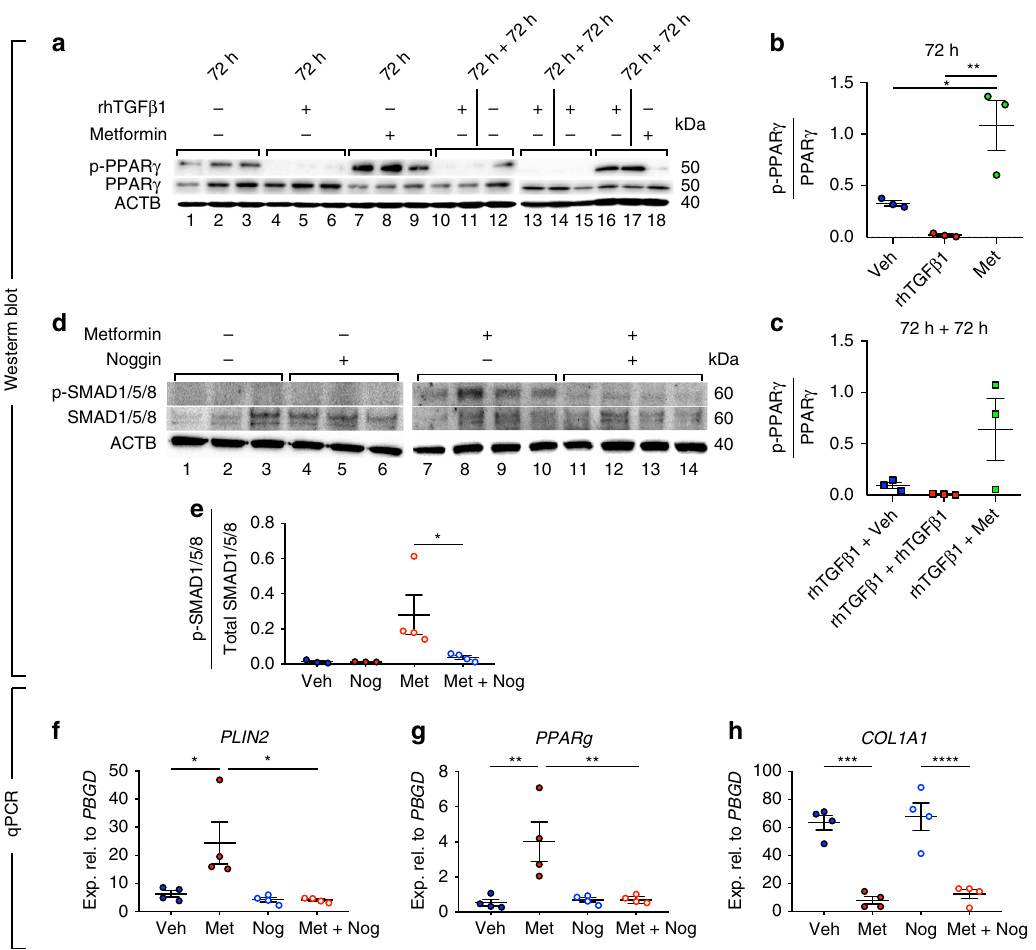
Fig. 7 Metformin-mediated lipogenic differentiation in human IPF lung fi broblasts is mediated by BMP2 signaling. a – c Western blot showing the opposing effects of metformin and rhTGF β 1 on PPAR γ phosphorylation and the ability of metformin to partially restore PPAR γ phosphorylation in rhTGF β 1-treated IPF fi broblasts. Lanes 1 – 12 and lanes 13 – 18 were run in parallel on different gels under the same conditions. d Western blot showing the phosphorylation status of SMAD1/5/8 in the presence of metformin and/or the BMP signaling inhibitor noggin. Quanti fi cation of the immunoblot is shown in ( e ). f – h qPCR analysis of PLIN2, PPARg , and COL1A1 in IPF fi broblasts treated with vehicle, metformin, noggin and noggin + metformin. Each data point corresponds to one patient and error bars indicate s.e.m. a – c n = 3 per group. d Vehicle- and noggin-treated groups: n = 3 per group, metformin- and metformin/noggin- treated groups: n = 4. f – h n = 4 per group. Kruskal – Wallis test was used in ( b , c , e – h ). * P < 0.05, ** P < 0.01, *** P < 0.001, **** P <